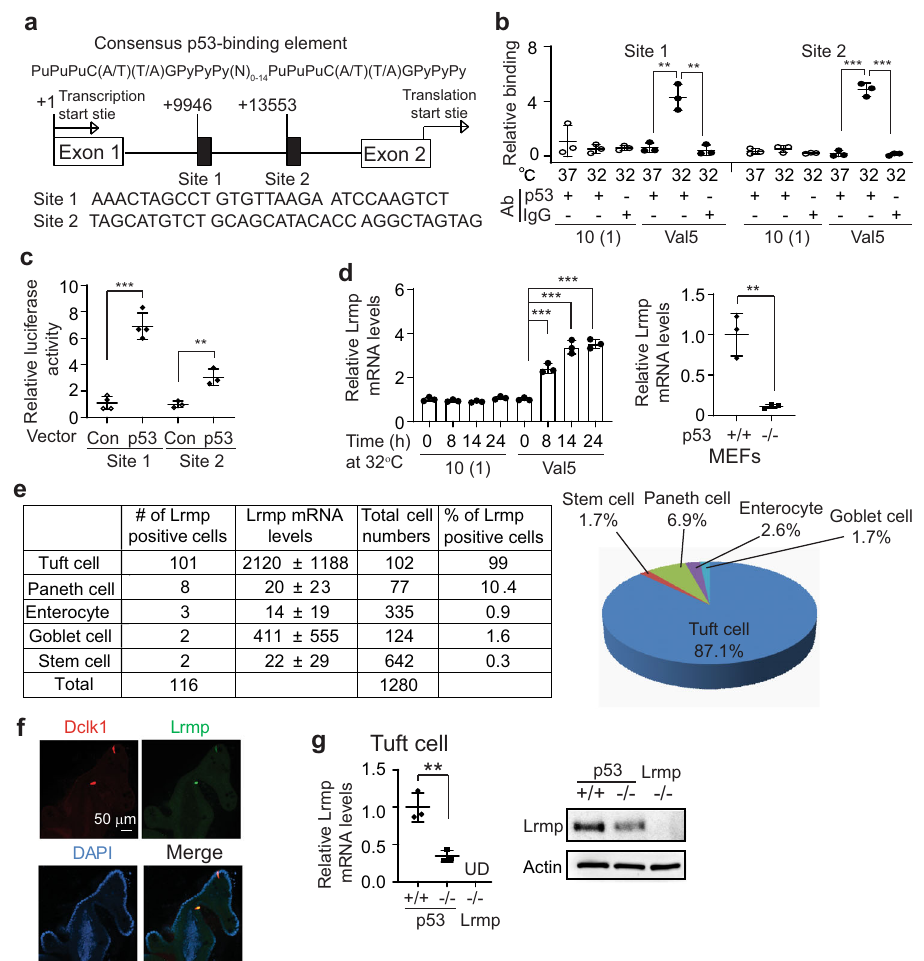
Fig. 3 Lrmp is a p53 target gene highly expressed in tuft cells. a The putative p53-binding elements in the Lrmp gene predicted by the p53MH program. A consensus p53-binding element is also presented. Pu, purine; Py, pyramidine; N, any nucleotide. b p53 bound to two p53-binding elements in Lrmp determined by ChIP assays. c Ectopic expression of p53 transactivated the p53-binding elements in Lrmp determined by luciferase reporter assays in p53 − / − MEFs. d p53 transcriptionally upregulated Lrmp expression. mRNA levels were determined by quantitative real-time PCR and normalized with β - actin. e Lrmp expression in mouse intestinal epithelial cells by analyzing a scRNA-seq dataset (GSE92332). f Co-localization of Lrmp and Dclk1 in tuft cells determined by IF staining of intestinal organoids. g Lrmp mRNA and protein levels in p53 + / + , p53 − / − and Lrmp − / − tuft cells determined by quantitative real-time PCR and Western-blot assays, respectively. For b , c , d , and g , data are presented as mean ± SD. ** p < 0.01; *** p < 0.001, two-tailed Student ’ s t - test. UD: